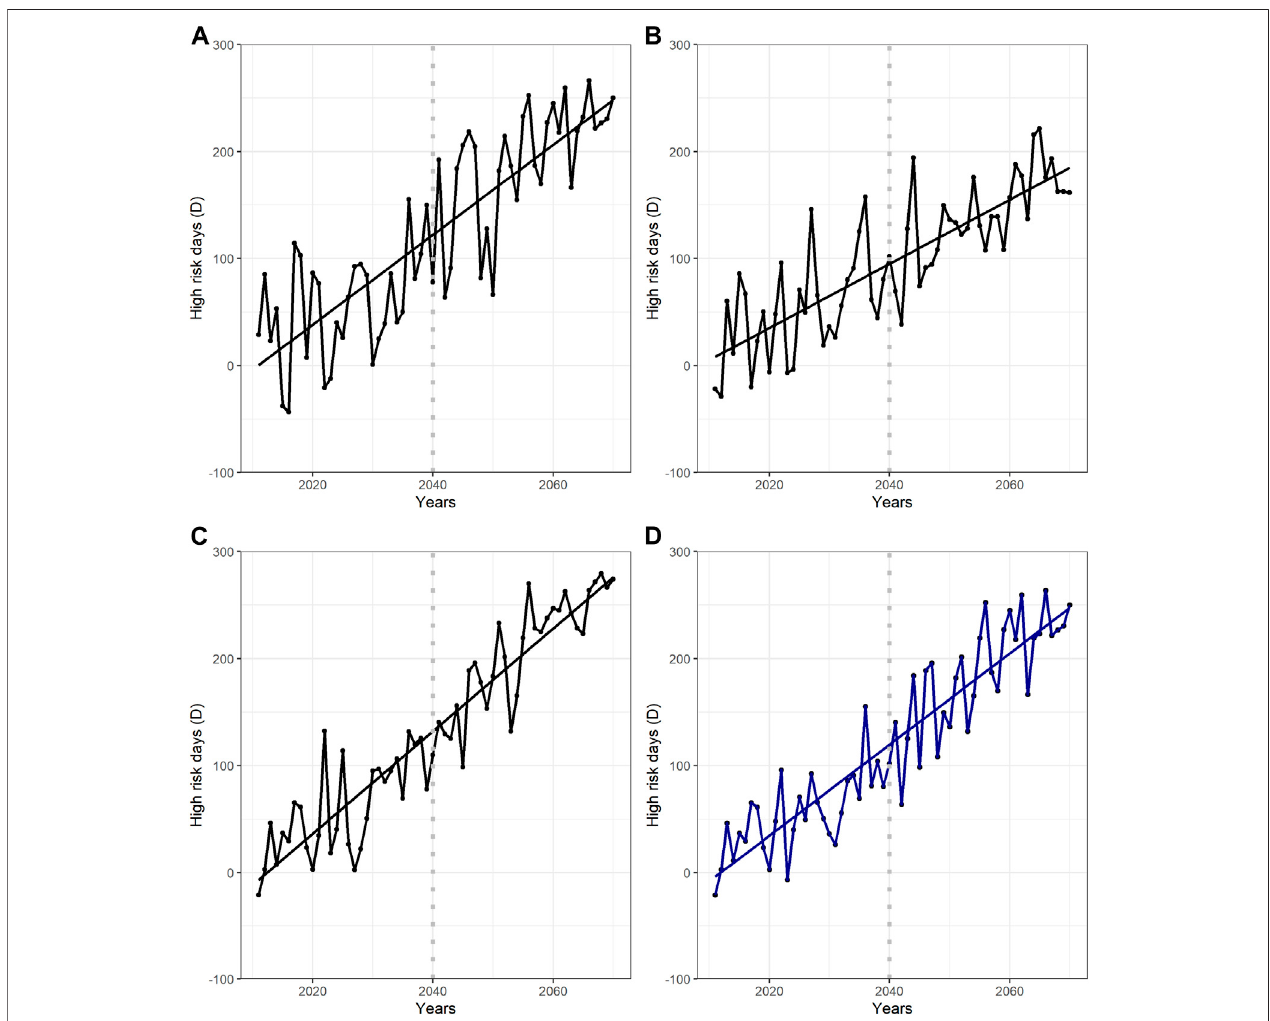
FIGURE 8 | HRD of temperature gauges in Ecuador from CSIRO (A) , GISS (B) , and IPSL (C) . (D) is the ensemble that explains the median from three WGCMs. Values of the HRD axis are between − 100 and 300 days.